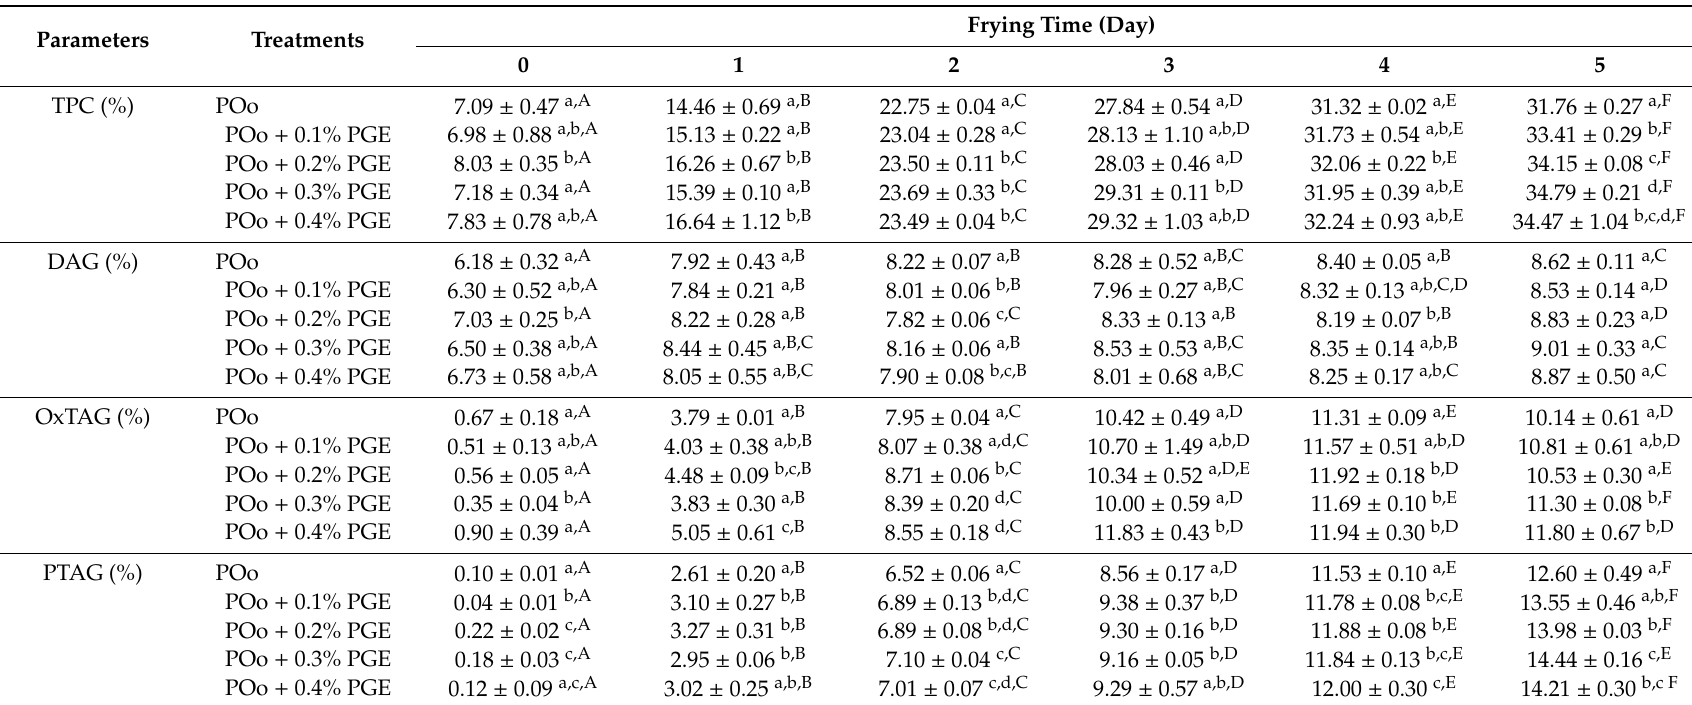
Means within a row for each parameter marked with the same lowercase letters are insignificantly di ff erent ( p < 0.05). Means within a column for each parameter marked with the same uppercase letters are insignificantly di ff erent ( p < 0.05). Abbreviations: TPC—total polar compounds; DAG—diacylglycerols; OxTAG—oxidised triacylglycerols; PTAG—polymerised